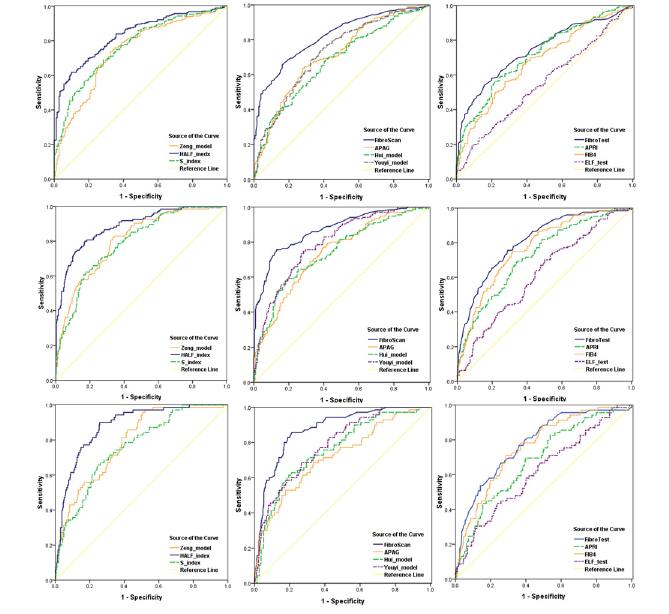
Fig 2. Receiver operating characteristic (ROC) curves for noninvasive models in the diagnosis of significant fibrosis (F2-4, A), advanced fibrosis (F3-4,B), and cirrhosis (F4, C).